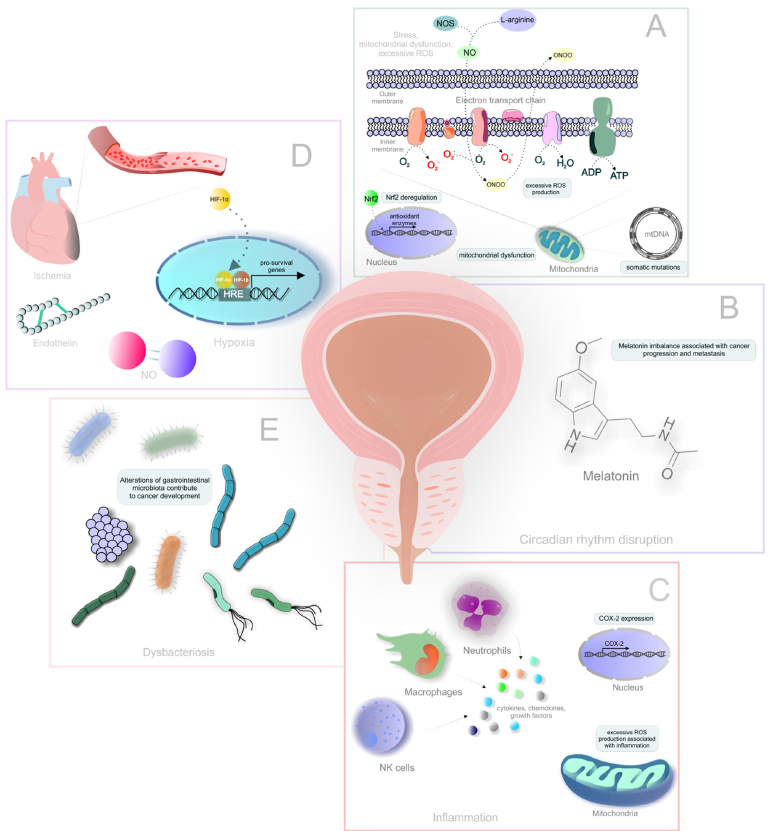
Figure 1. Systemic effects involved in PCa development and progression. Explanatory notes: ( A ) mitochondrial dysfunction, excessive ROS, oxidative stress; ( B ) circadian rhythm disruption; ( C ) inflammation; ( D ) hypoxia; ( E ) dysbacteriosis.